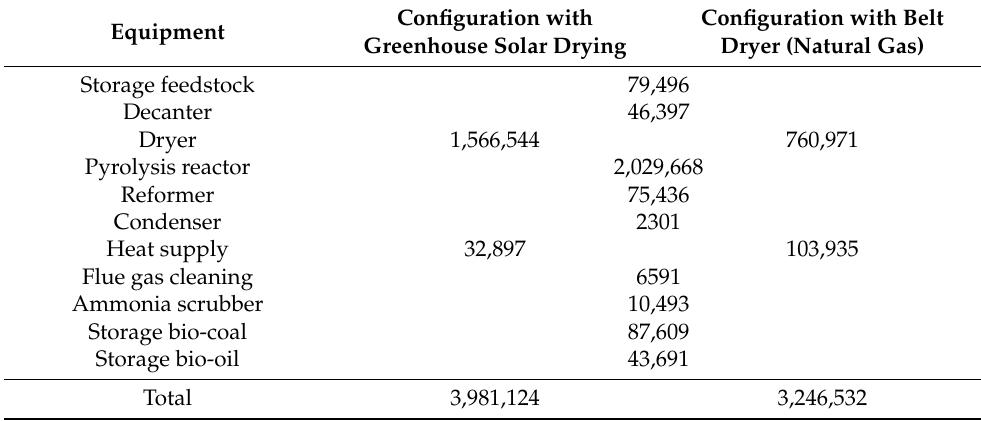
Table 4. Installed equipment cost in EUR (base case with 3577 tons bio-char per